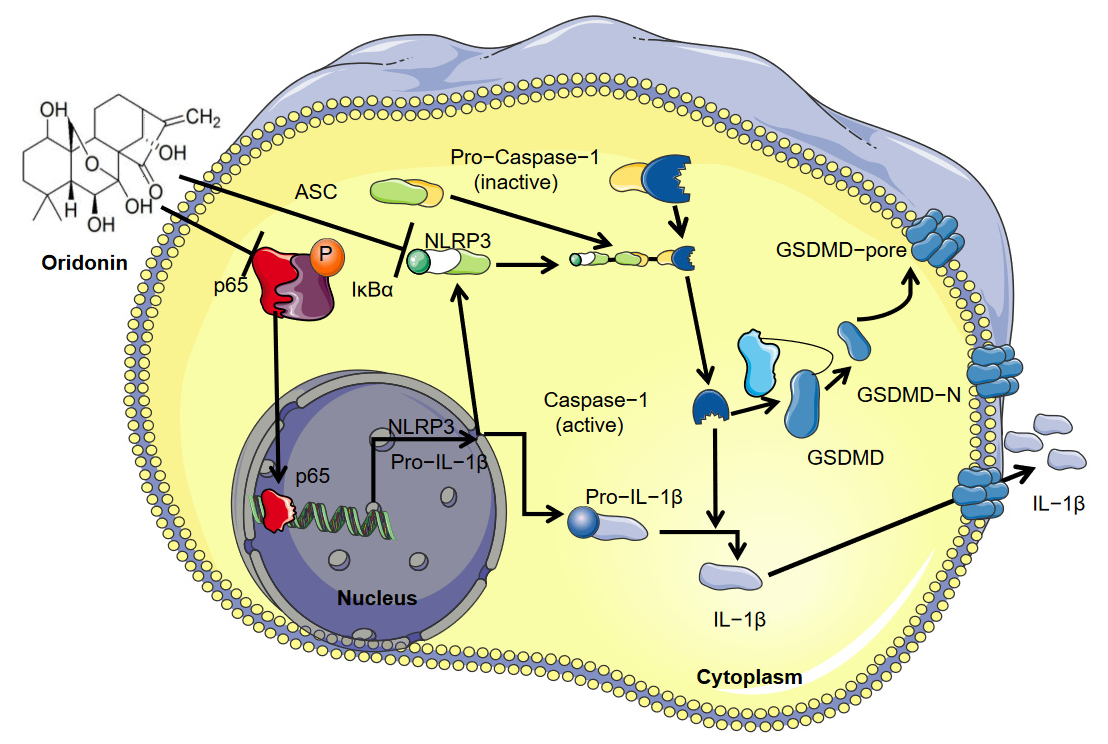
Figure 6. A schematic representation of the protective effect of oridonin during ischemia-reperfusion injury in the heart by inhibiting GSDMD-mediated pyroptosis.